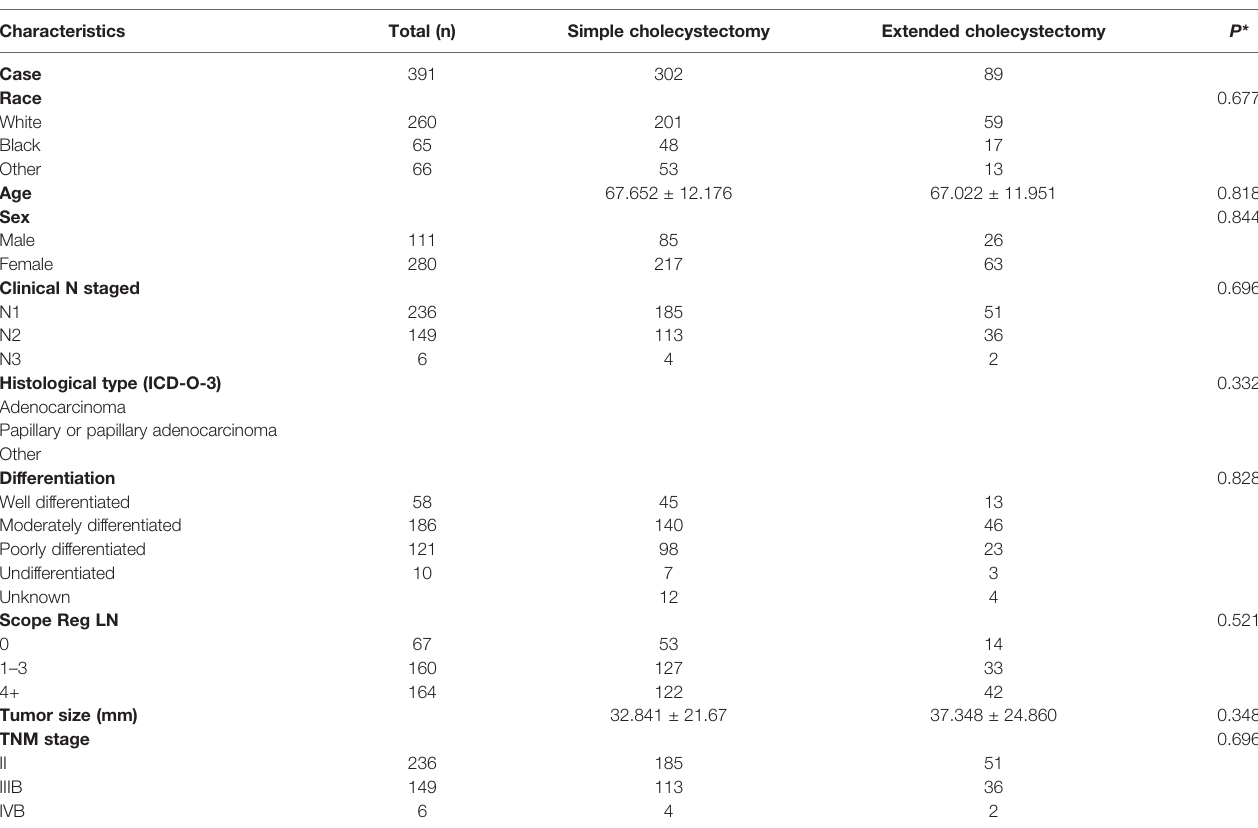
TABLE 2 | Patient baseline characteristics after propensity score matching.